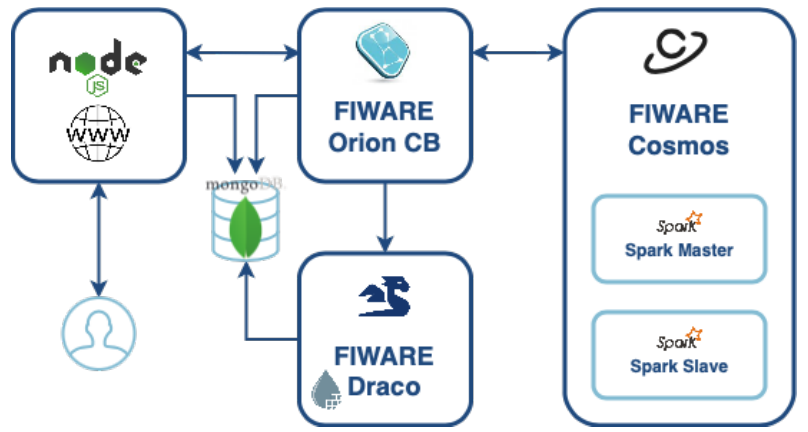
Figure 9. Service components of the purchase prediction system.